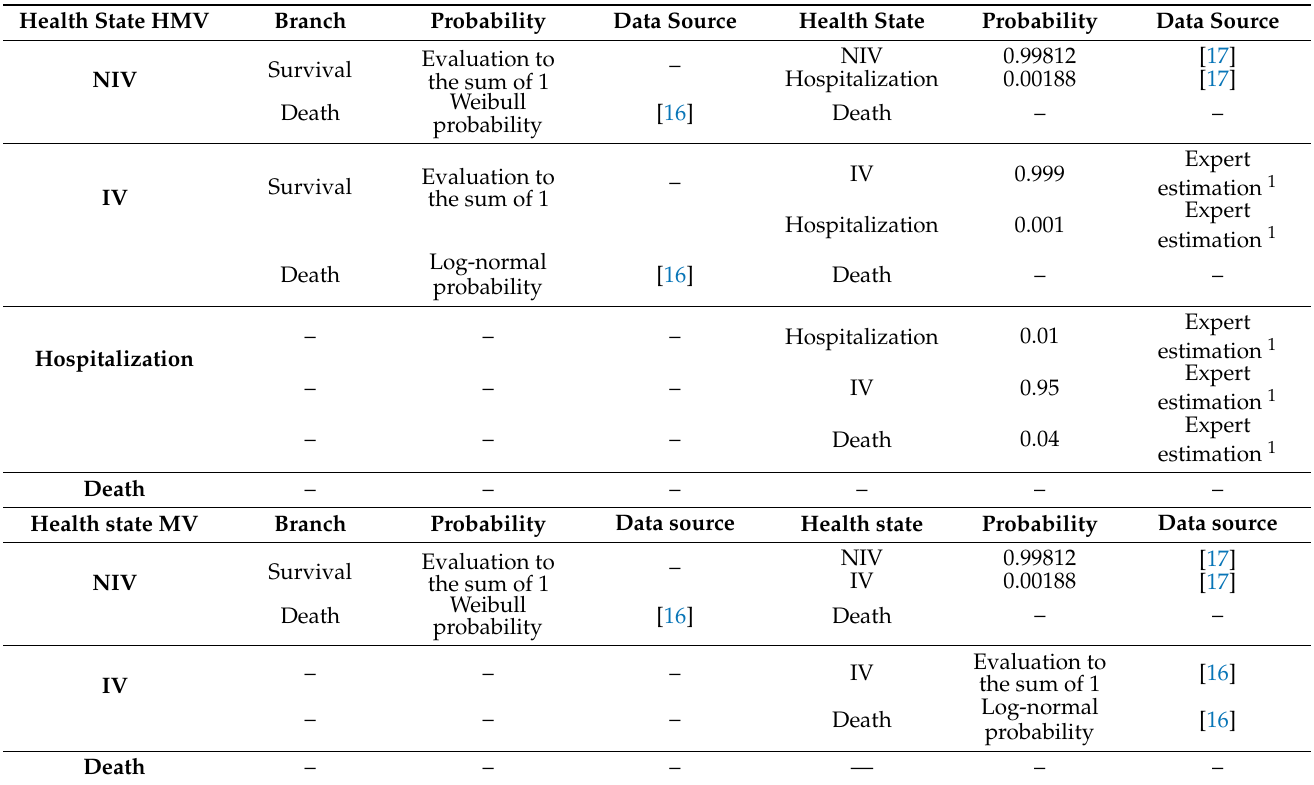
Table 1. Health states and probabilities of mutual